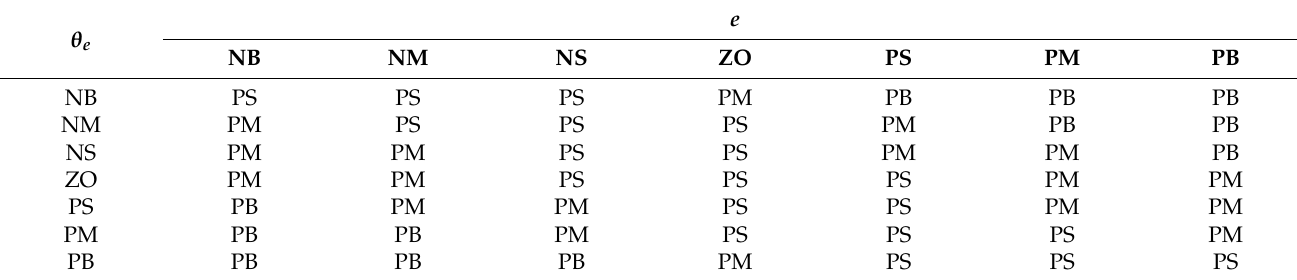
Table 1. Rule base for fuzzy logic